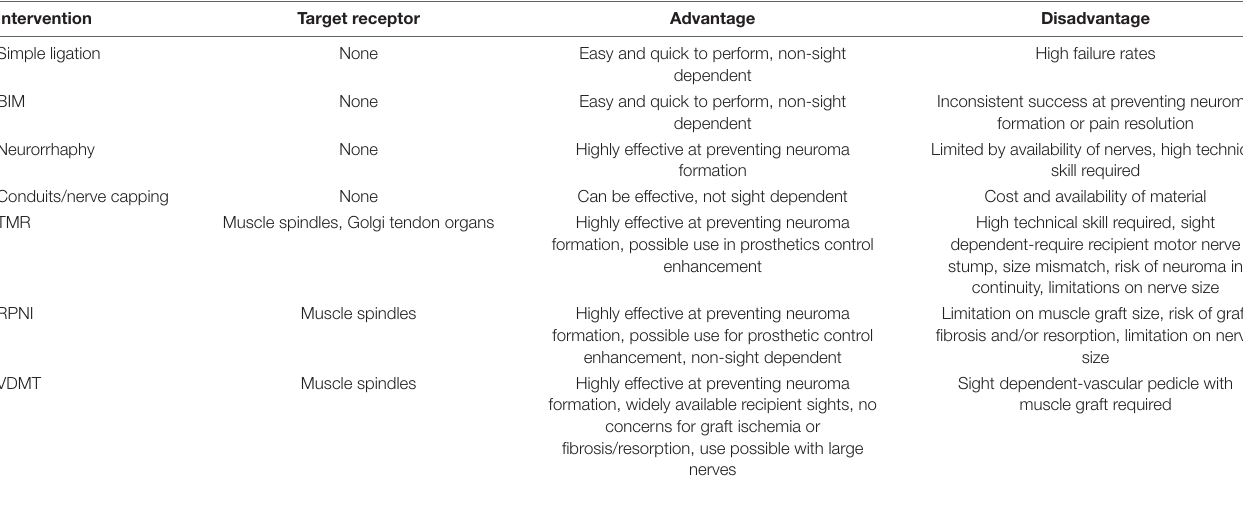
TABLE 2 | Advantages, disadvantages, and target receptors in surgical interventions. Intervention Target receptor Simple ligation